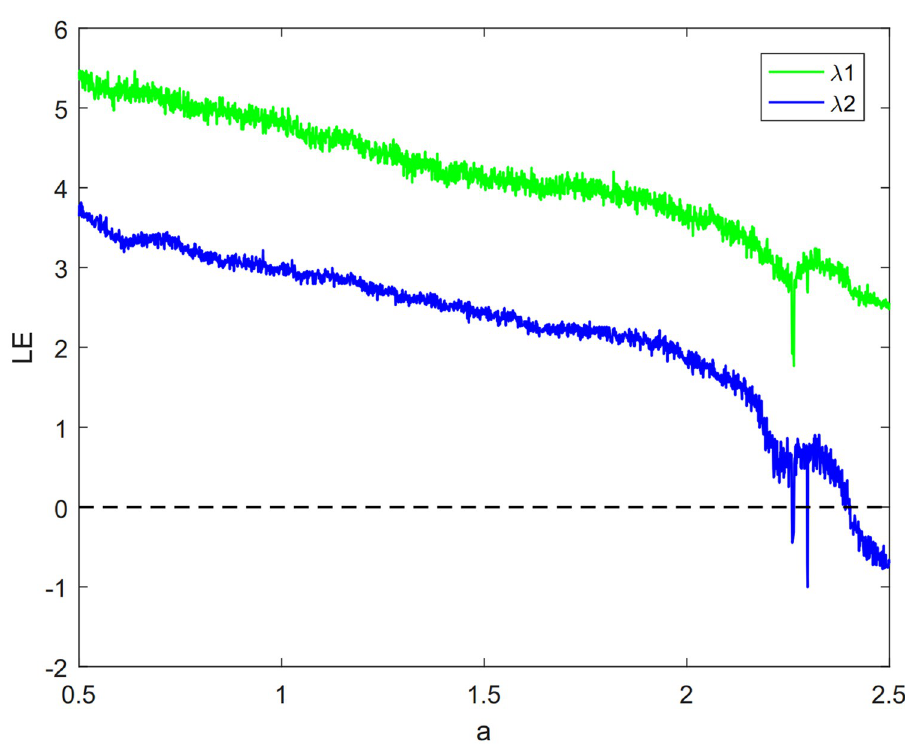
Fig 2. Lyapunov spectrum of 2D-LICM chaotic system with a from 0.5 to 2.5.